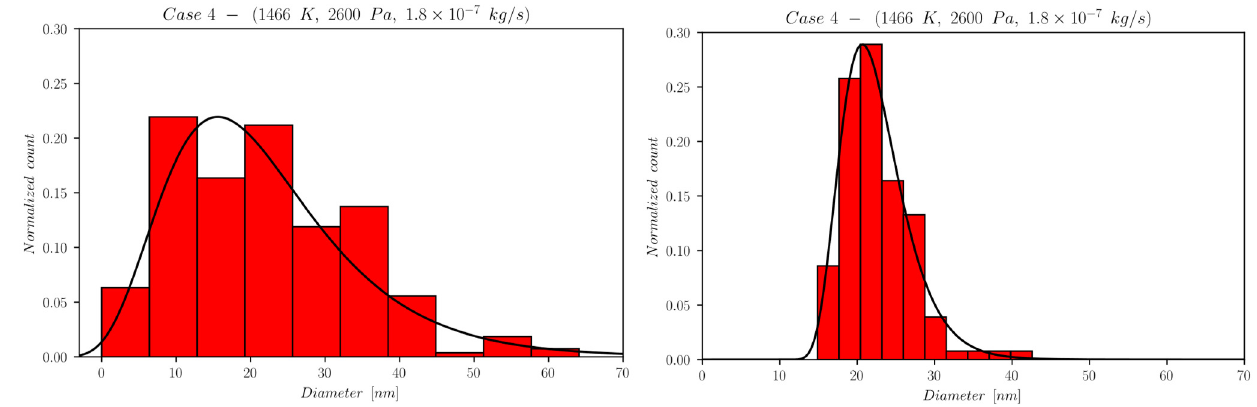
Figure 11. Final PSD for case 5; ( left ) PBM predictions and ( right ) experimental results. The He mass flow rate effect suggests an anticipated NP formation for case 5 (higher flow) compared to case 2 (lower flow), due to the GP cooling effect discussed previously. The quantitative consequences on the final NPs’ size distribution are a narrower range of values and a shift toward smaller diameters, as can be verified by looking at Table 3. The higher the flow, the quicker the NPs attain a size plateau where they stop growing. The dominant influence of temperature on the process, as highlighted by the previous set of results, is confirmed. In fact, the predicted PSDs for case 2 and 5 lie in the same range, with only a slight shift in the latter toward a lower diameter in spite of the doubled flow rate.